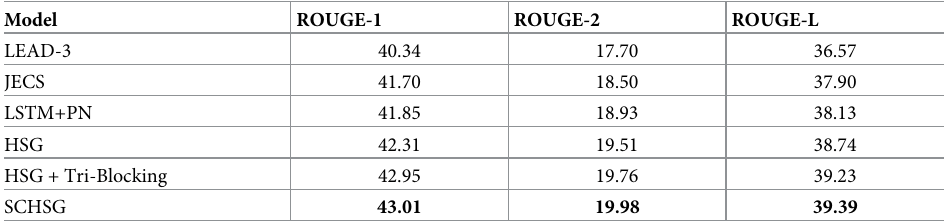
Table 2. The results of sentence centrality-enhanced EDS model based on HSG.